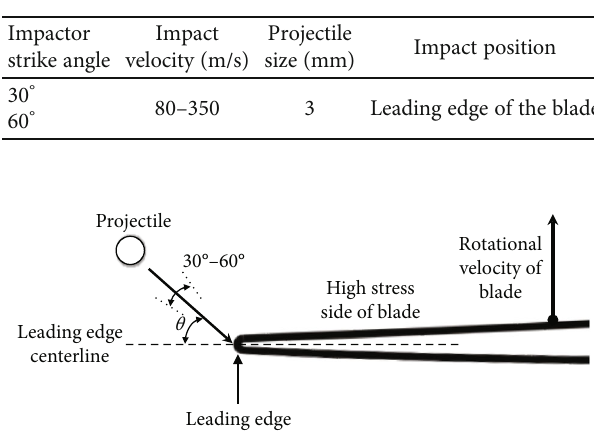
Figure 4: Schematic of the SHPB test equipment. Table 1: The protocol for FOD tests.